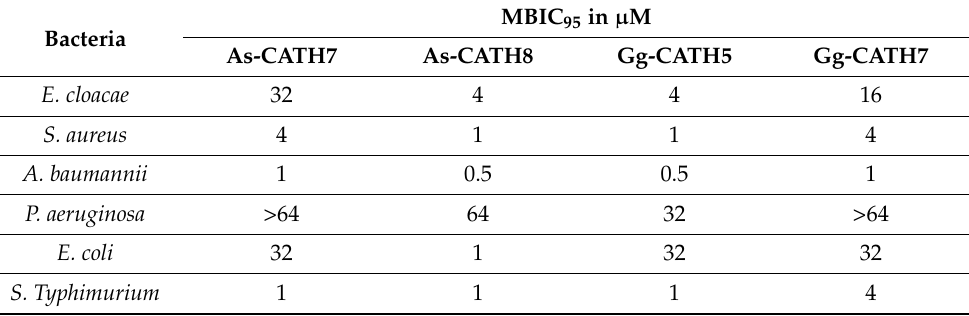
Table 3. Biofilm inhibitory activity of the crocCATHs. The MBIC 95 values of the synthetic peptides were determined by a microdilution assay using crystal violet to stain the adhered bacterial biomass. MBIC 95 was defined as the minimal peptide concentration capable of inhibiting mean biofilm growth by at least 95% compared to the untreated control. Values in µ g/mL can be found in Supplementary Table